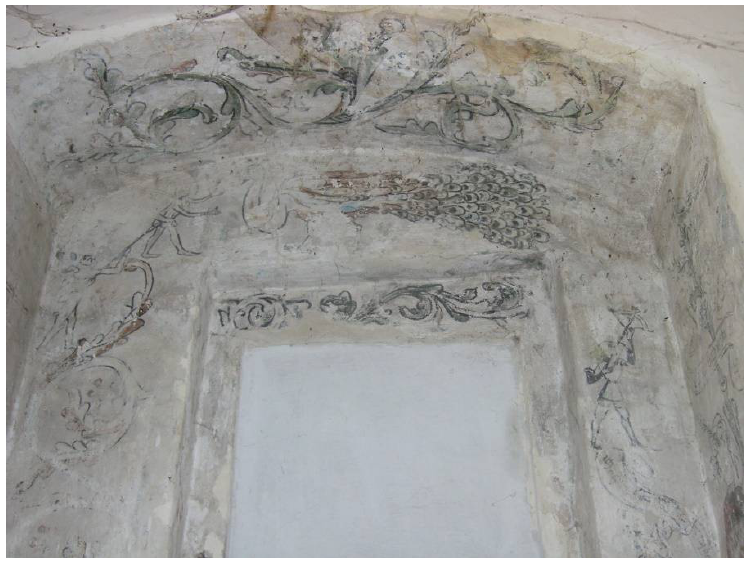
Figure 30. Witków, tower. Dwarfs hunting peacock and dove. Around 1450. Photo by Dagmara Adamska, the author’s own work.